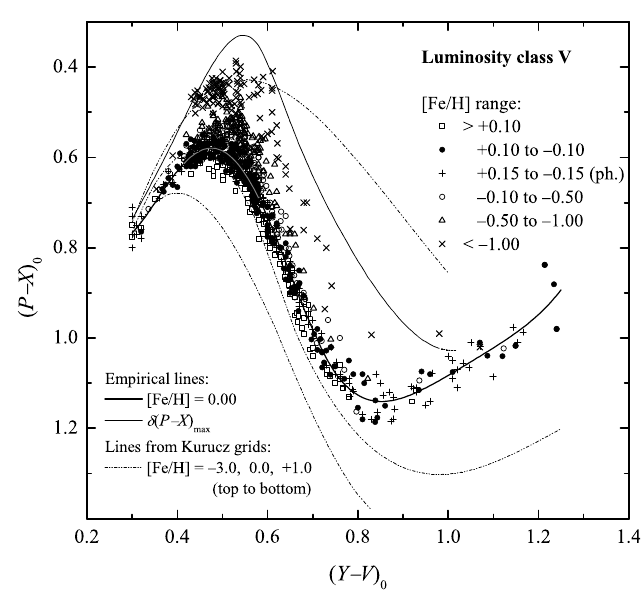
Fig. 4a. P – X vs. Y – V diagram for dwarf stars. Symbols indicate stars having [Fe/H] estimates from high-dispersion spectra, except for small thin crosses, which indicate stars having only photometric [Fe/H]. For more explanations, see text in x 3.2.